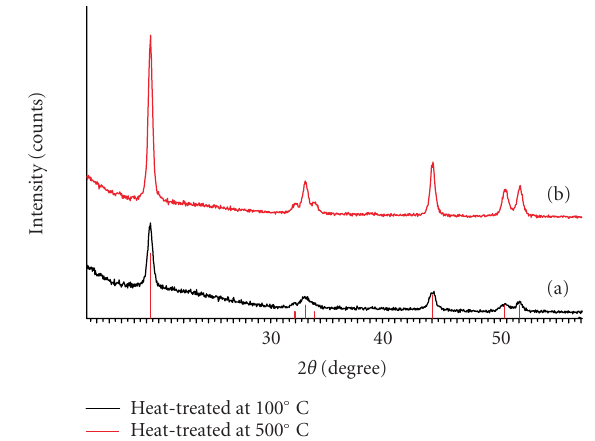
Figure 4: SEM images of the composite nanostructure TiO 2 film with MC after heat treatment at 500 ◦